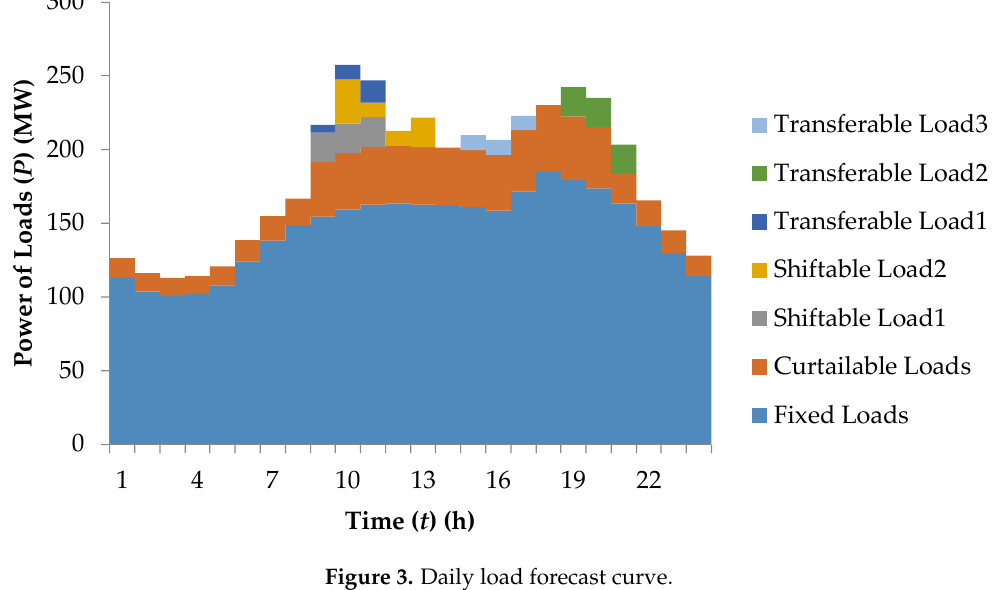
Figure 3. Daily load forecast curve.